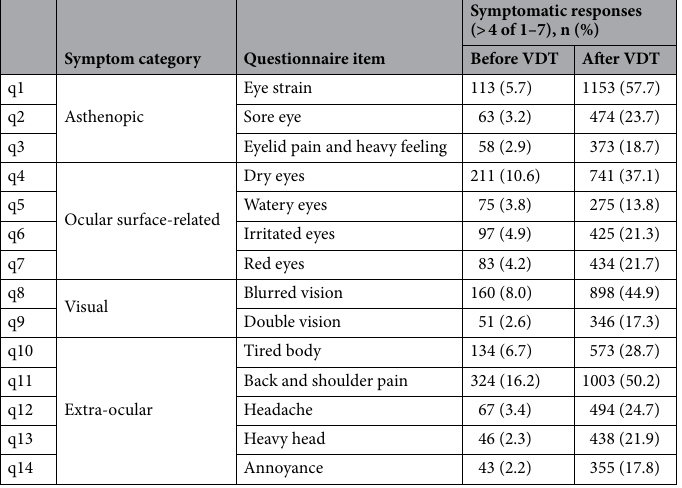
Table 2. List of CVS-related questionnaires and statistics on responses. “Eye strain”, “blurred vision”, and “back and shoulder pain” have also been reported as common symptoms in digital device users from other studies 44,45 . In contrast, the prevalence of “headache” in this study were relatively lower, but this corresponds to another study on Japanese population 46